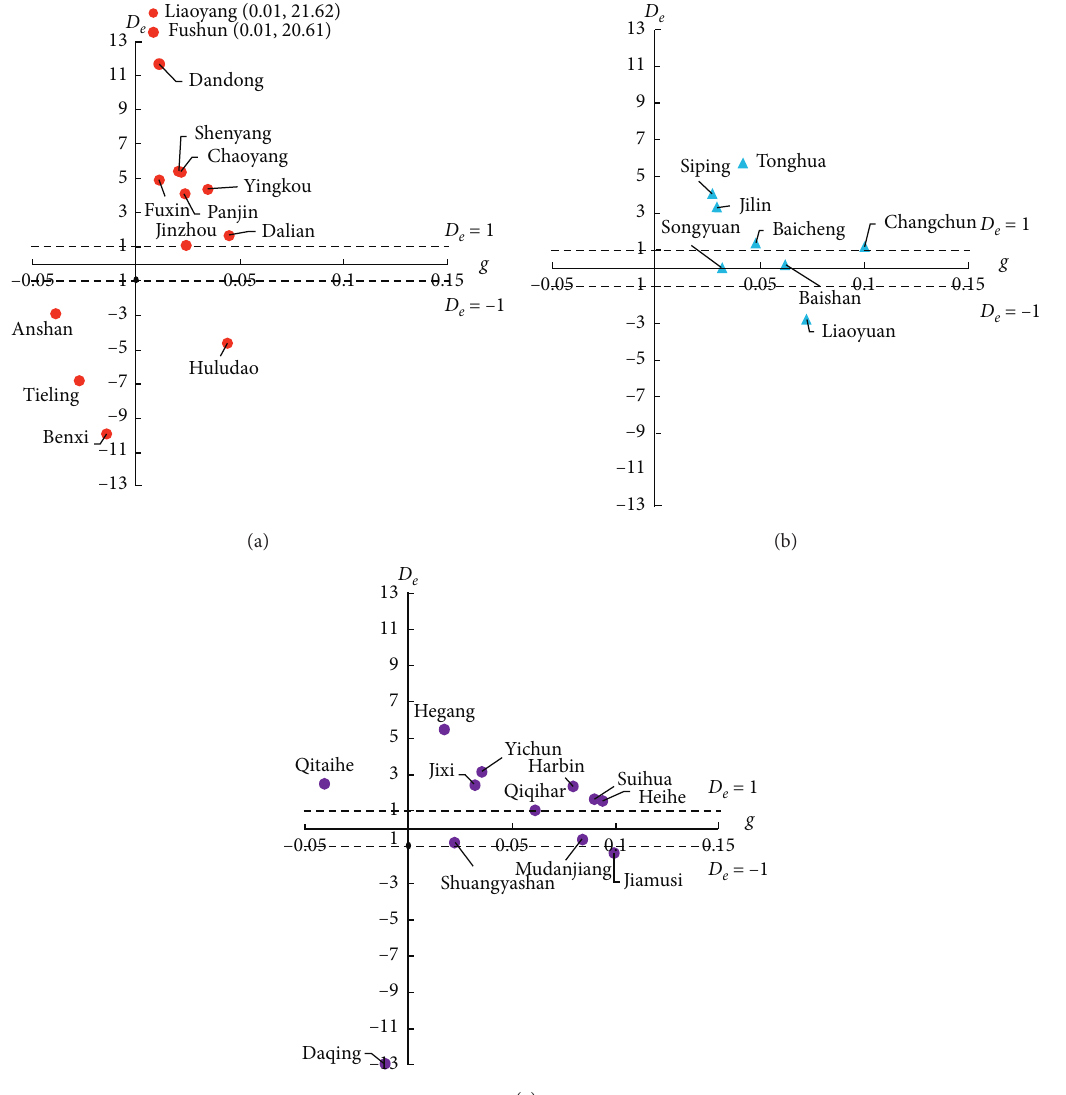
Figure 12: Decoupling chart of the carbon emissions of infrastructure construction for 34 cities in Northeast China from 2010–2017 (a) shows the decoupling of the carbon emissions of infrastructure construction in 14 cities of Liaoning province. (b) shows the decoupling of the carbon emissions of infrastructure construction in eight cities in Jilin province. (c) shows the decoupling of the carbon emissions of infrastructure construction in 12 cities in Heilongjiang province. D e � decoupling indicator for the material consumption of infrastructure; g � geometric average of gross domestic product (GDP) growth rate in a certain